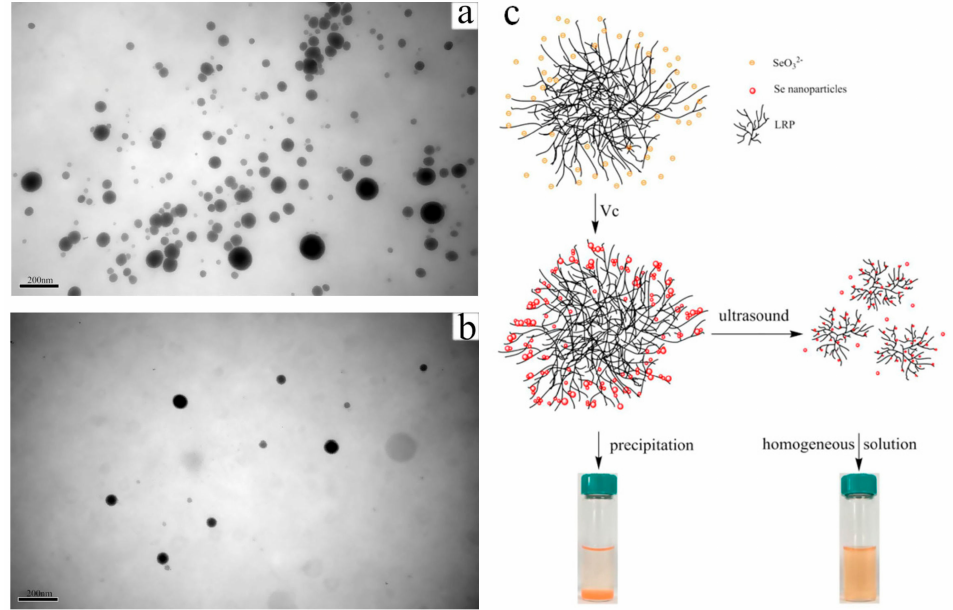
Figure 3. TEM images of LRP-SeNPs ( a ) and U-LRP-SeNPs ( b ) at the Se/LRP ratio of 1/10 in water. Schematic illustration ( c ) for the influence mechanism of ultrasound on LRP-SeNPs